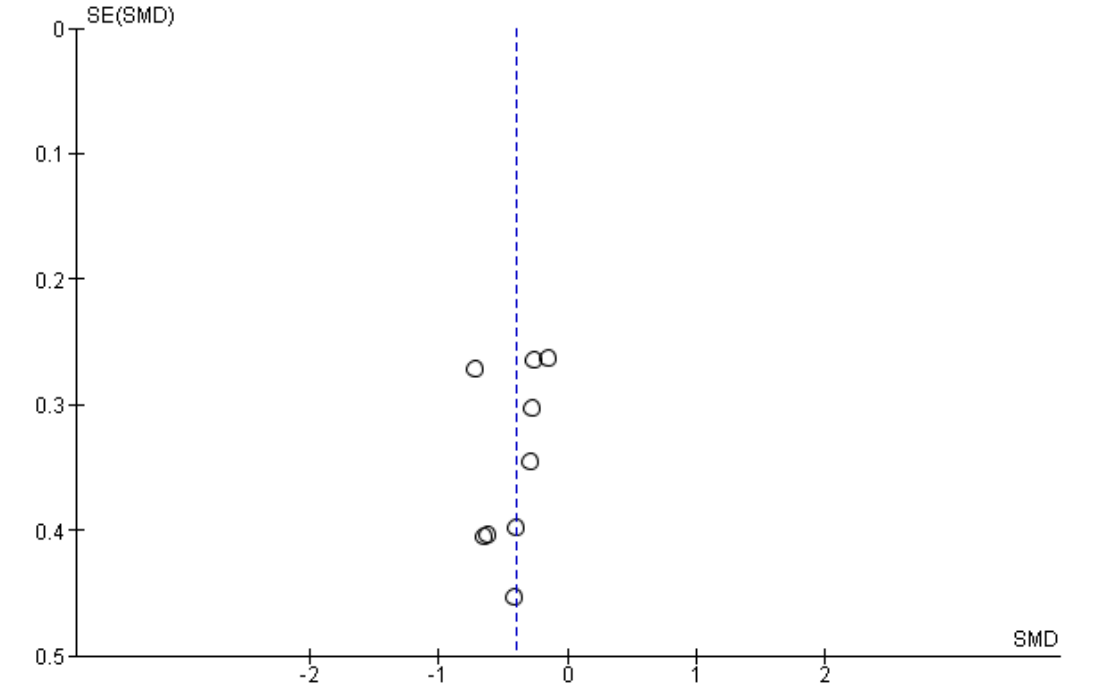
Figure 6. Depression post- vs. pre-nature walk funnel plot.